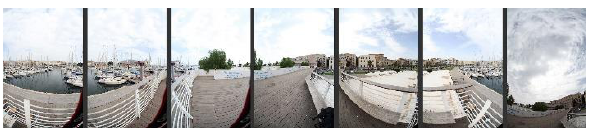
Figure 11: Fish-eye photos taken from a station point.